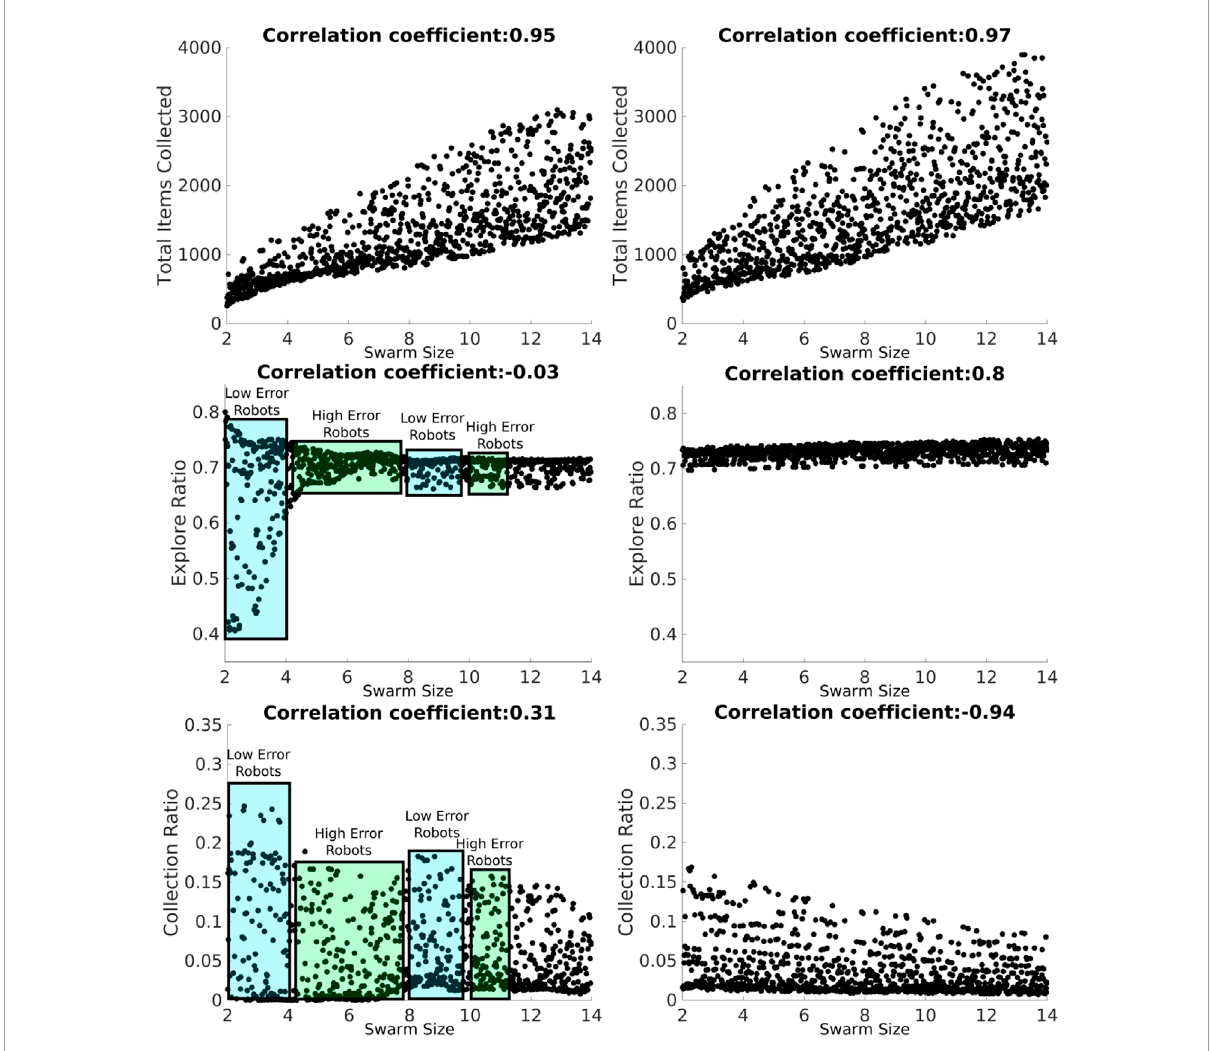
FIGURE 8 LHA for the swarm size term for the NPS with heterogeneous (left column) and homogeneous (right column) errors and for the total items collected (top row), explore ratio (middle row), and collection ratio (bottom row) outputs. The blue rectangles represent the proportion of low-error robots, and the green box represents the proportion of high-error robots. Robot individual error models introduce fluctuations with the heterogeneous error as shown with the explore ratio and collection ratio . However, this does not happen with the homogeneous error because all the robots share the same error